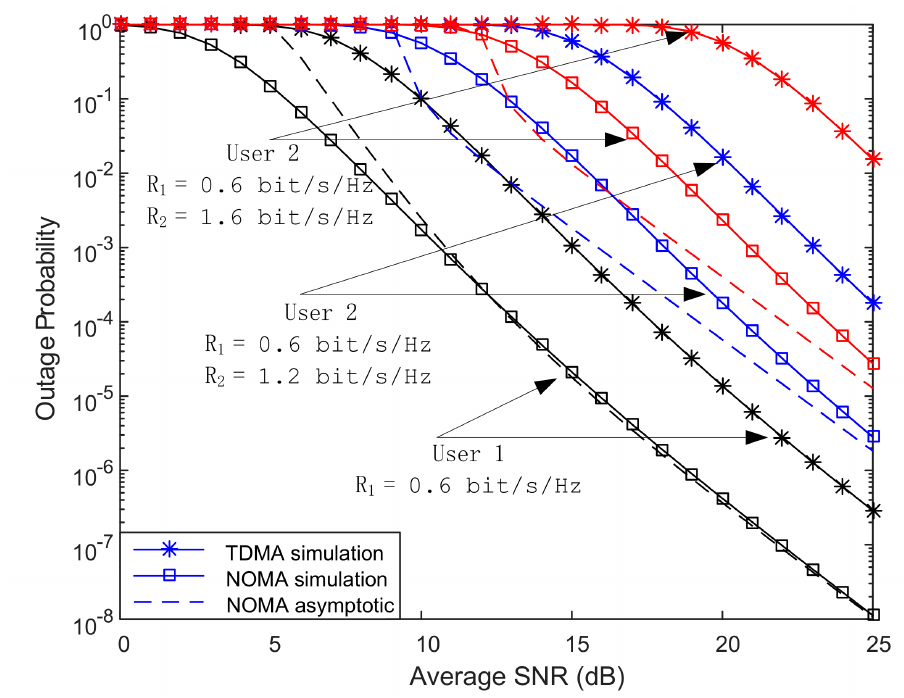
Figure 4. Outage probability vs. SNR for di ff erent target